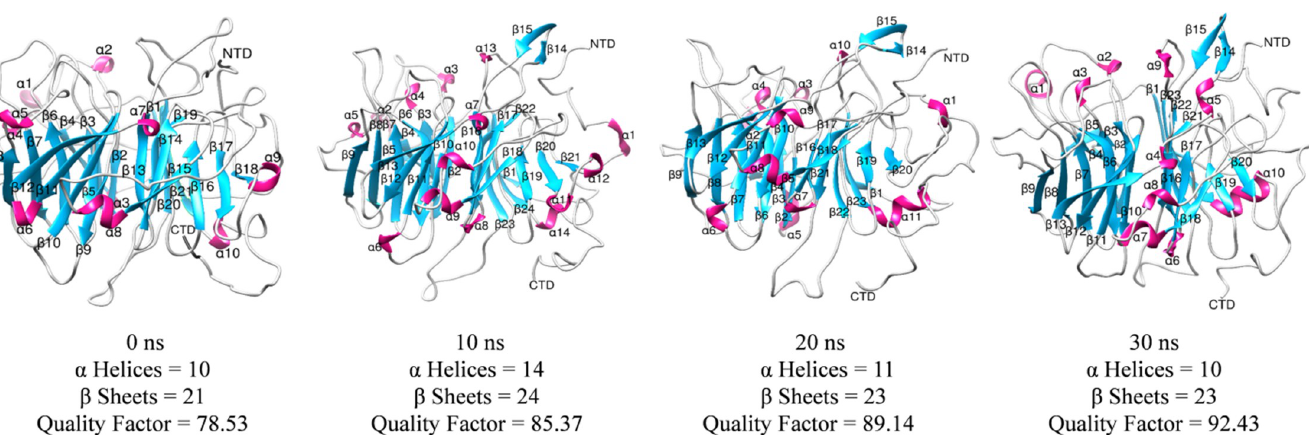
PLOS ONE | https://doi.org/10.1371/journal.pone.0228265 February 3,